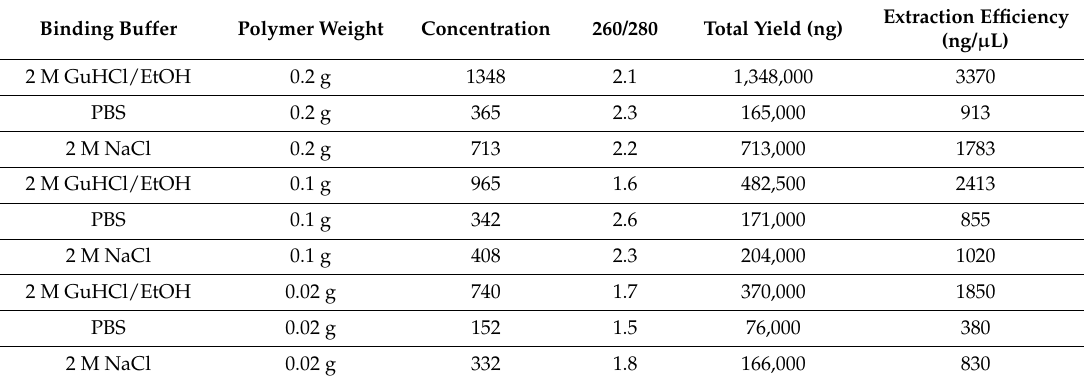
Table 6. Extraction efficiencies and total yields of DNA for the poly(4,4 (cid:48) -cyclohexylidene bisphenol oxalate)/Si (13%) NC when tested under different weights and binding buffers.